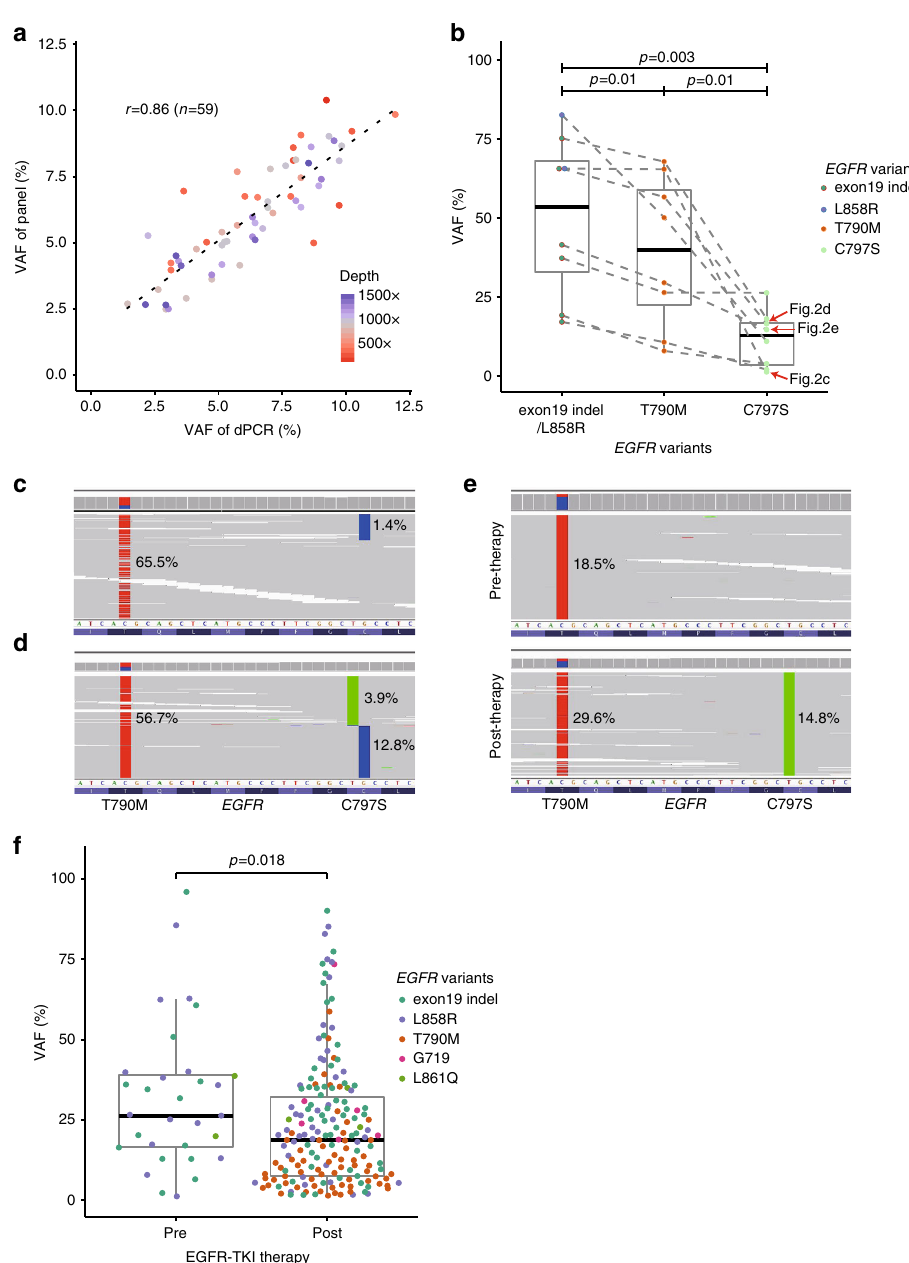
Fig. 2 Features of actionable mutations with low VAF. a Concordance between VAFs estimated from panels and dPCRs for low VAF variants. The Pearson correlation coef fi cient based on 59 actionable variants is 0.86. Variants with higher coverage (colors correspond to sequencing depths) tend to show higher correlation; also see Supplementary Data 4. b Differences in VAF distributions among EGFR mutations in eight refractory lung cancer samples harboring EGFR C797S. All samples had an activating mutation ( EGFR exon19 non-frameshift (NFS) deletion or L858R) and two resistance mutations ( EGFR T790M and C797S), with the latter occurring at lower VAF. Dotted lines indicate mutations belonging to the same sample. The P -values were calculated using the paired t -test. c , d Browser view of the case in which EGFR C797S occurred in cis with EGFR T790M (only a subset of the reads are shown). e An acquired EGFR C797S mutation is found after AZD9291 therapy. f Comparison of VAF of EGFR variants of lung cancer samples ( n = 141) pre- and post- EGFR-TKI therapy (afatinib, erlotinib, or ge fi tinib). The P values were calculated using the Wilcoxon rank sum